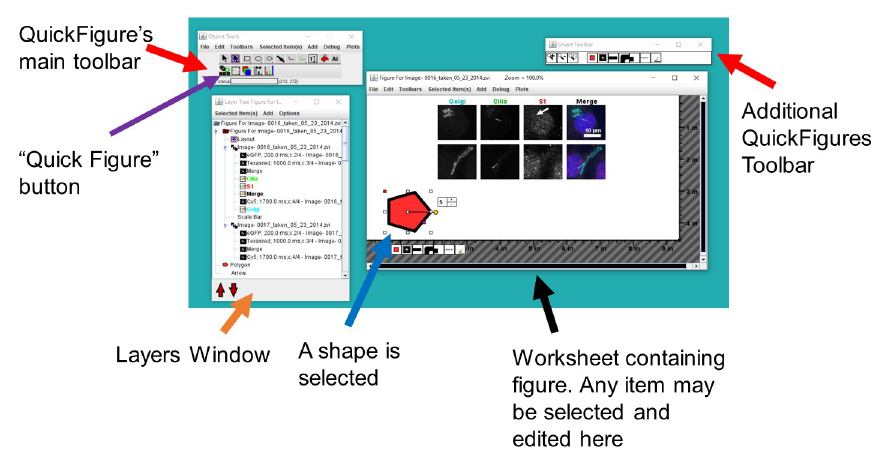
Fig 1. The QuickFigures user interface. An open figure is displayed. Black arrow points to the worksheet window where nearly all edits are performed with the mouse. Red arrows indicate toolbars. The main toolbar on the left contains drawing tools, the ‘Quick Figure’ tool and the ‘Inset’ tool indicated by violet arrow. A single pentagon is drawn and selected to demonstrate drawing and object selection. All objects can be selected and edited. The layers window displays a list of layers and objects (orange